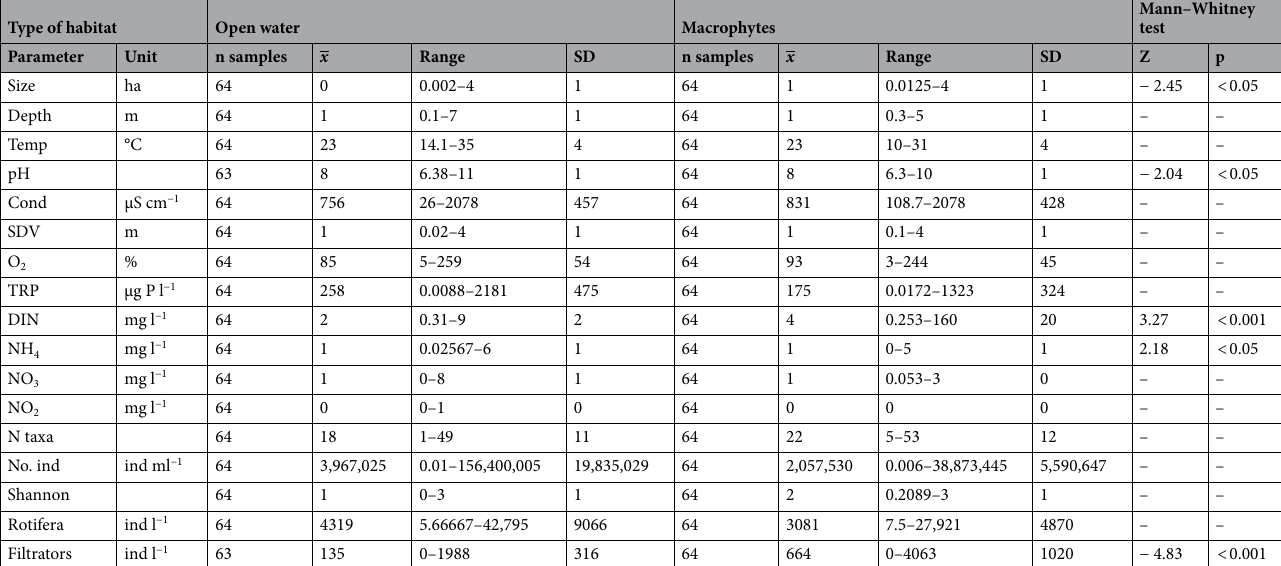
Table 3. Limnological parameters (SDV—Secchi disc visibility), number of chlorophytes taxa (N taxa) and individuals (No. ind.), phytoplankton diversity (Shannon—Shannon–Wiener Diversity Index) and zooplankton (Rotifera, Filtrators) abundance of different pond habitats (open water vs. macrophyte-dominated zone). The results of the Mann–Whitney test are